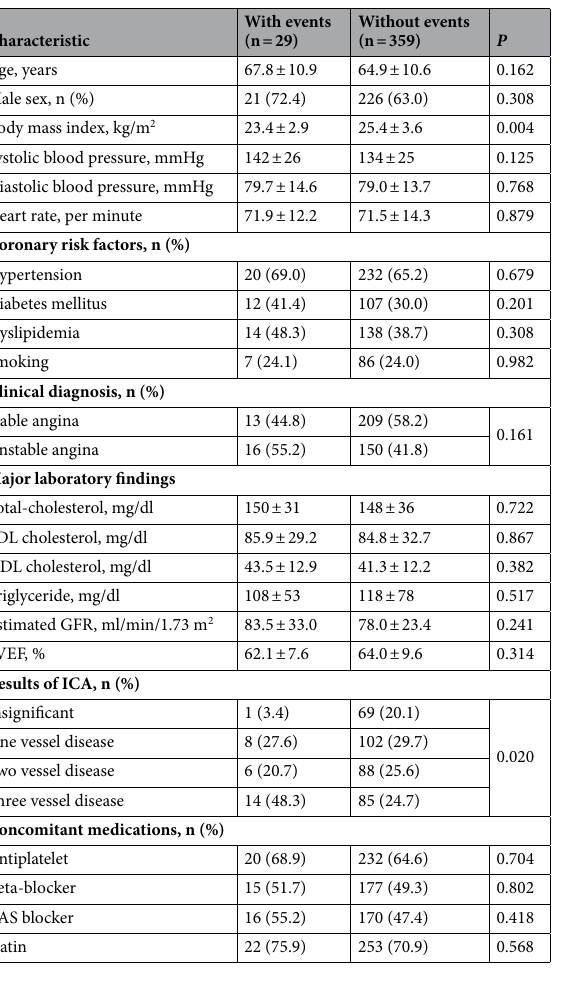
Table 1. Baseline clinical characteristics of study patients. LDL low-density lipoprotein, HDL high-density lipoprotein, GFR glomerular filtration rate, LVEF left ventricular ejection fraction, ICA invasive coronary angiography, RAS renin-angiotensin